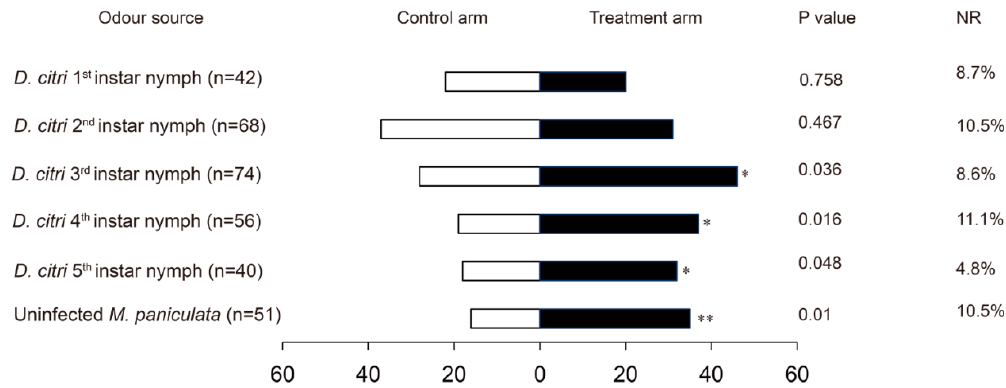
Figure 1. Response of female Tamarixia radiata to odours emitted from Murraya paniculata or Diaphorina citri nymphs versus blank controls, respectively, within a Y-tube olfactormeter. * indicates significant differences between the white bars and black bars (* P < 0.05, ** P < 0.01). NR: percentage of non-responders.